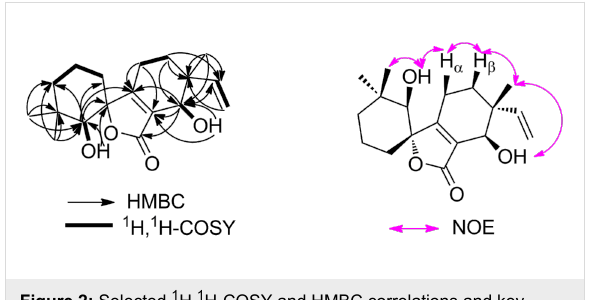
Figure 2: Selected 1 H, 1 H-COSY and HMBC correlations and key NOEs observed for 1